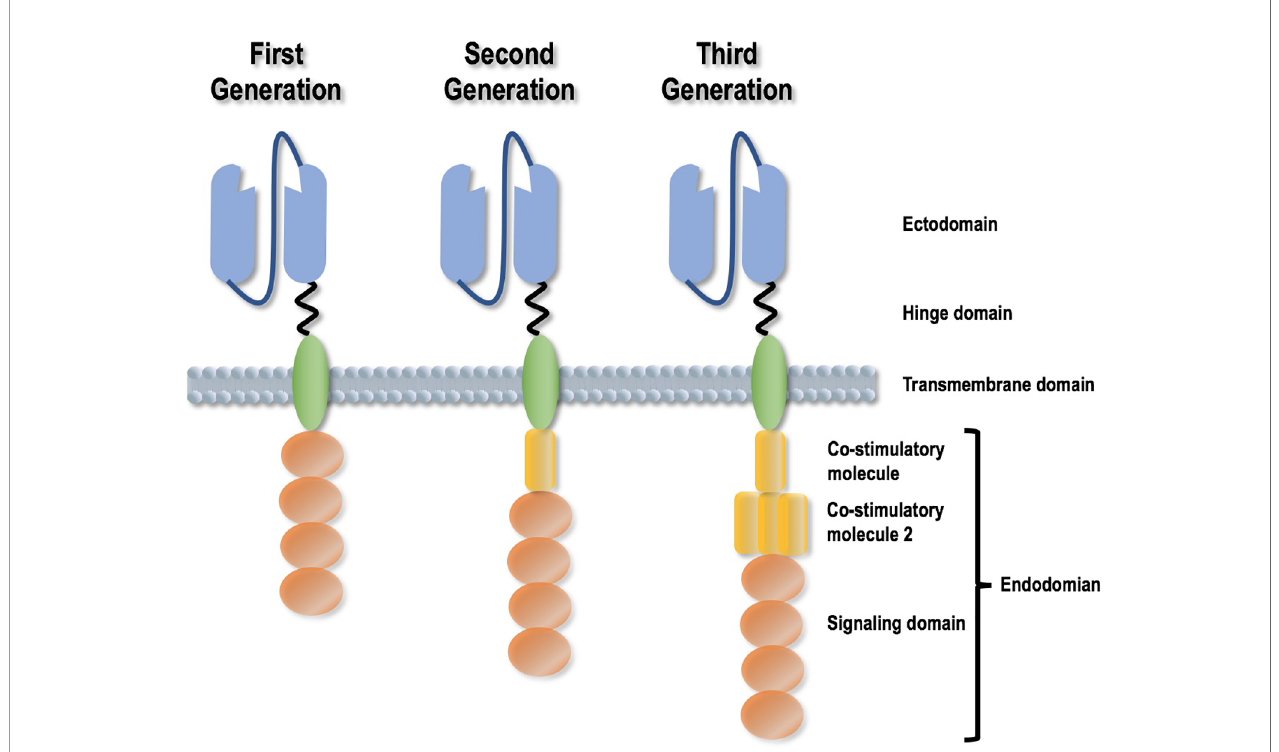
FIGURE 2 | Different generations of Chimeric Antigen Receptor design strategies. A CAR is comprised of four domains, i.e., an ectodomain that is responsible for tumor antigen recognition, an endodomain that contains one or several stimulatory molecules helping T cells persist, a hinge domain, and a transmembrane domain. CAR design has experienced three generations, with the differences re fl ected by the presence, ef fi cacy and amount of co-stimulatory molecules.